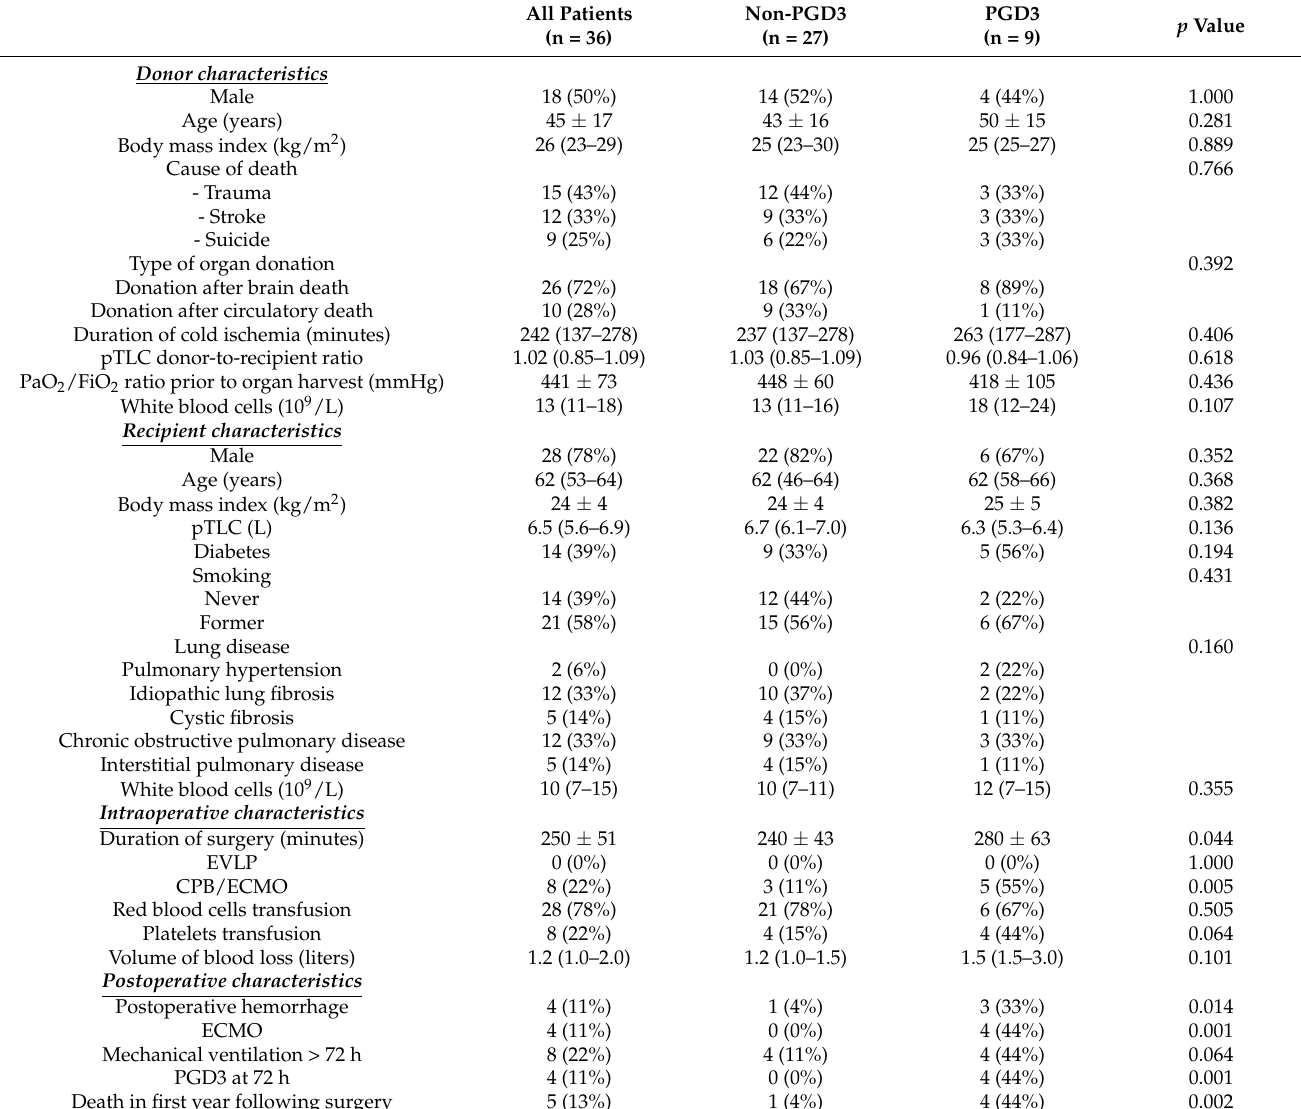
Table 1. Pre-, intra- and postoperative characteristics of donors and recipients undergoing bilateral lung